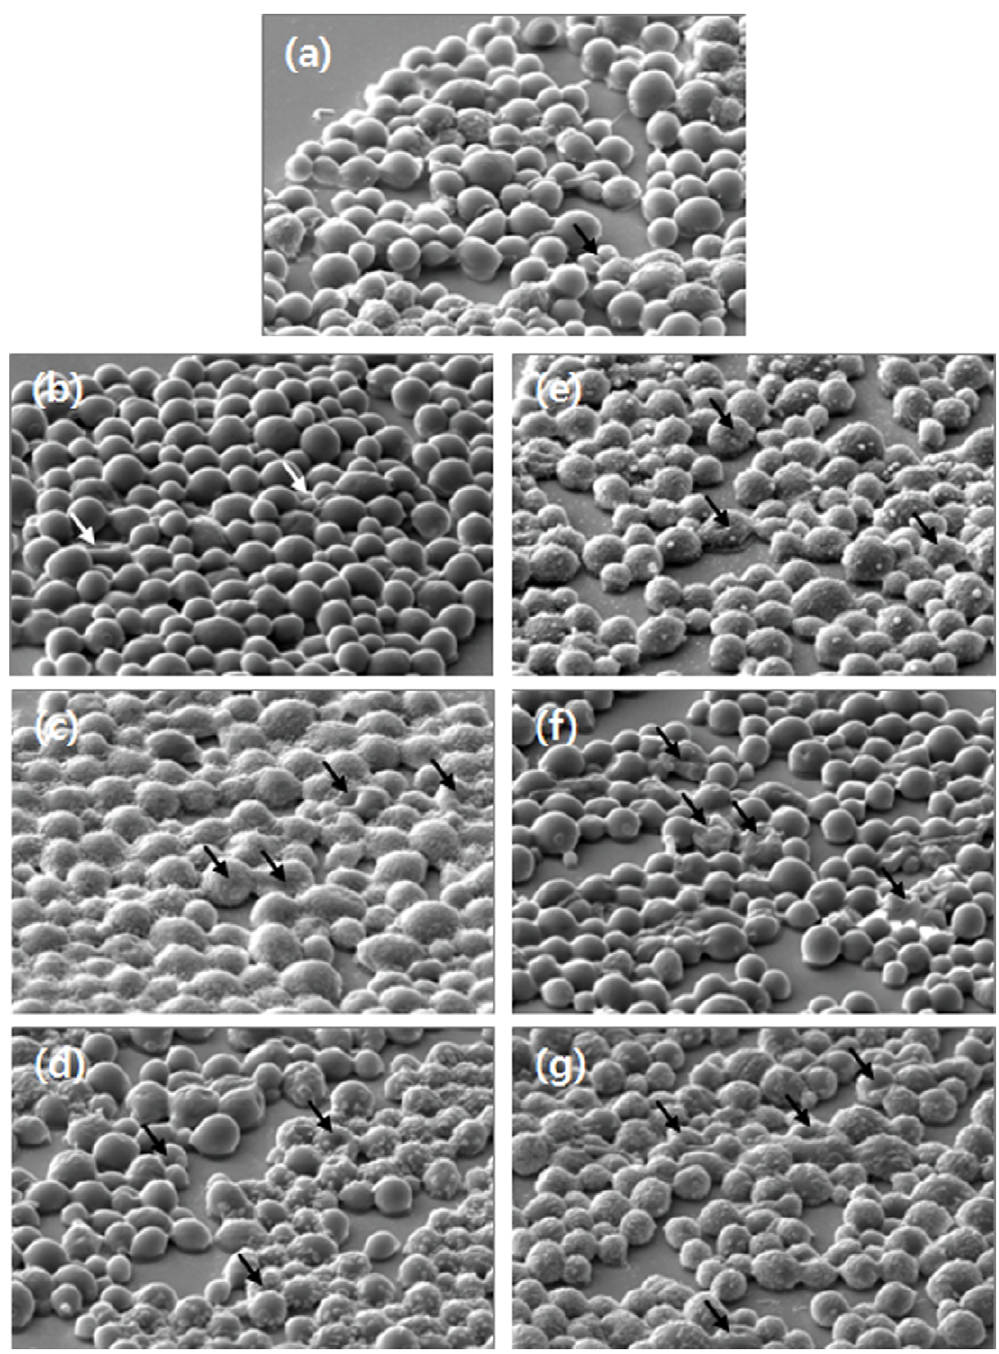
Figure 2. SEM images of C.albicans treated with allicin or antifungal drugs for 24 hours. (a) Control cells. The images shown in (b)–(g) are of cells treated with allicin alone, AmB, flucytosine, AmB + allicin, flucytosine + allicin, and AmB + flucytosine + allicin, respectively.